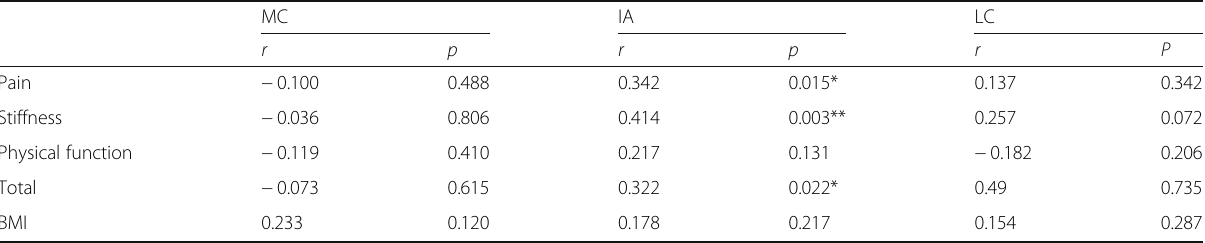
Table 3 Correlation between femoral cartilage thickness and WOMAC index subclasses MC IA LC r